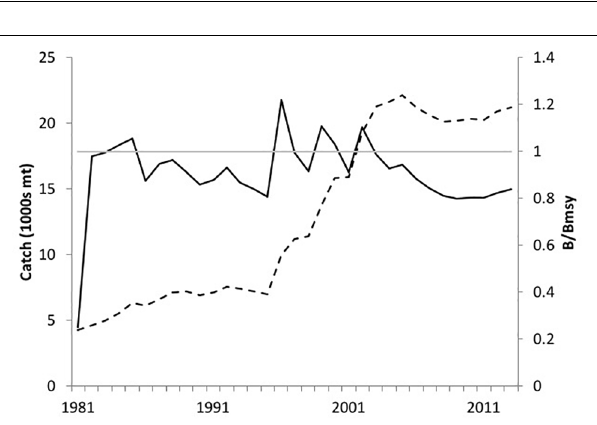
FIGURE 5 | Sustainability analysis for sharks based on estimated B/B MSY using catch reconstructions for foreign and domestic fleets in Somali waters. When estimated catch (dashed line) exceeds B/B MSY (solid line), the fishery is classified as